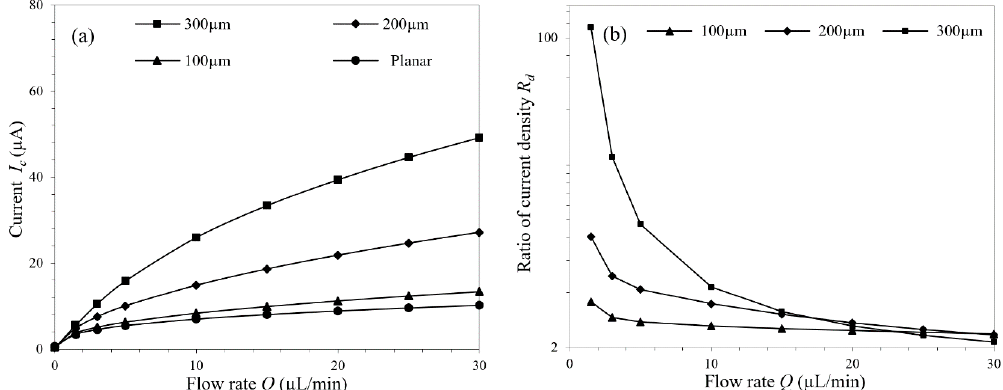
Figure 6. ( a ) Current responses of the planar electrode and the µ AEs with micropillars of di ff erent heights under varying flow rates; ( b ) The current density ratios of the µ AEs with micropillars of di ff erent heights under varying flow